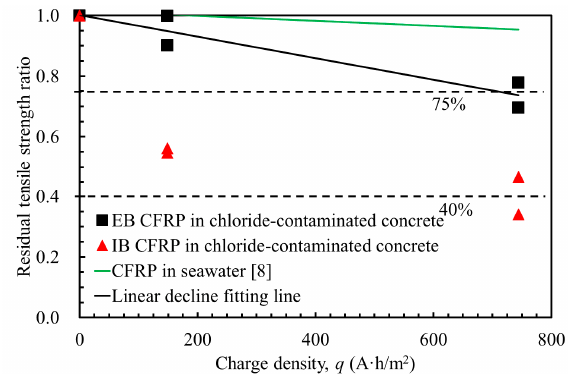
Figure 12. Residual tensile strength of the CFRP.